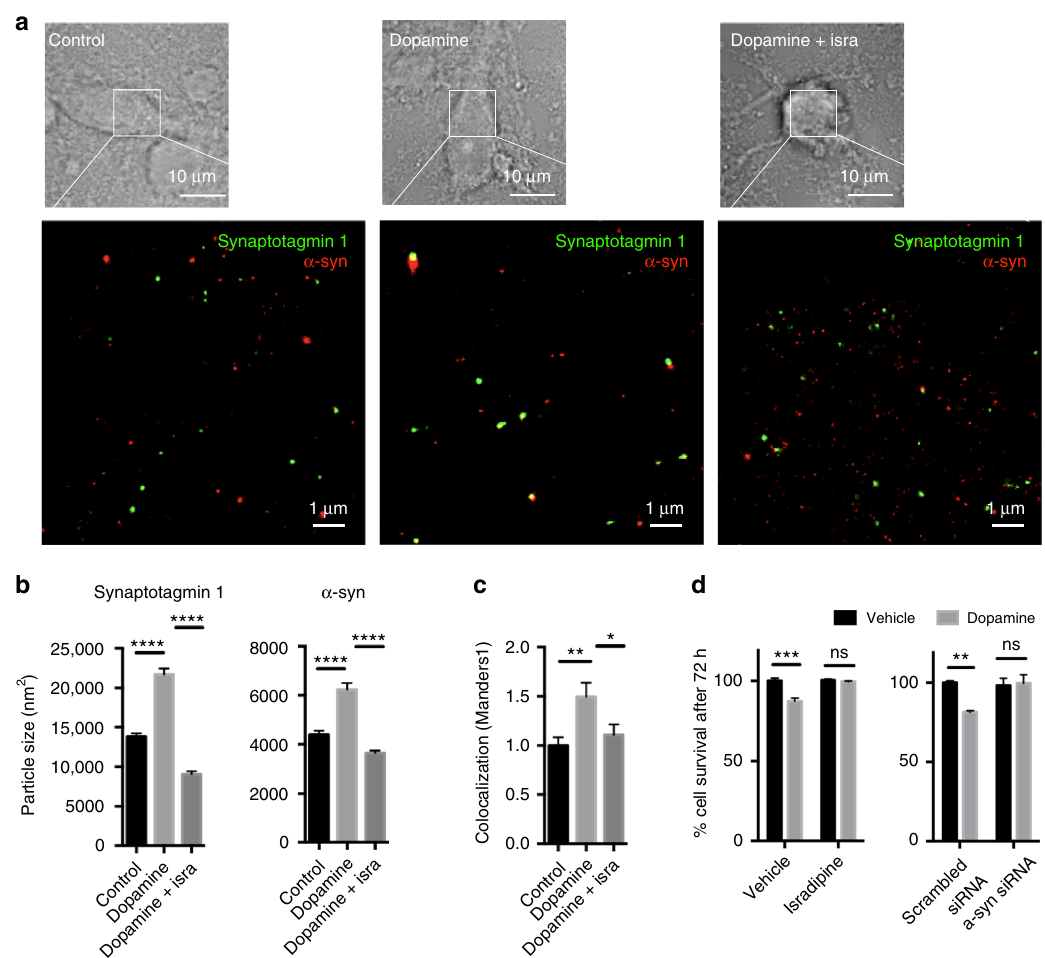
Fig. 4 Calcium and alpha-synuclein levels mediate dopamine toxicity. a - c Ventral midbrain neurons were incubated with 100 µ M dopamine in the presence or absence of 5 µ M isradipine. d STORM super-resolution microscopy of alpha-synuclein and synaptotagmin-1 after 72 h revealed an increase in the area of alpha-synuclein puncta, an increase in the size of synaptotagmin-1 puncta and an increased co-localization of alpha-synuclein with synaptotagmin-1